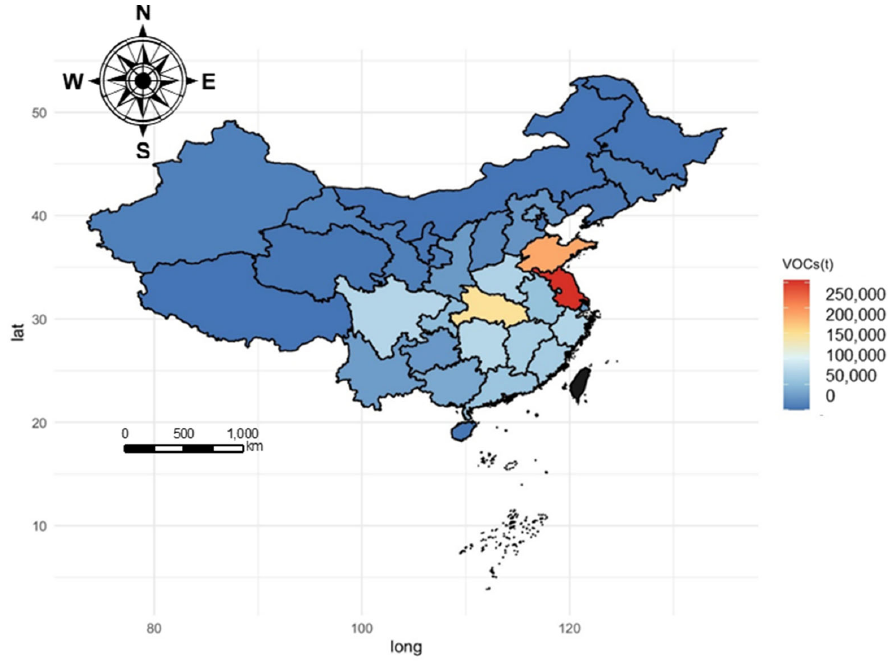
Figure 5. Spatial pattern of building industry VOCs emissions in China by province and city in 2030.